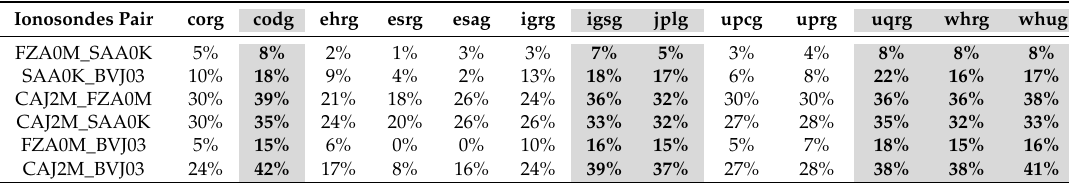
Table 5. Rates of improvement considering one-year (2015) mean RMS values of the di ff erences between fo F 2 values measured and estimated with GIMs.